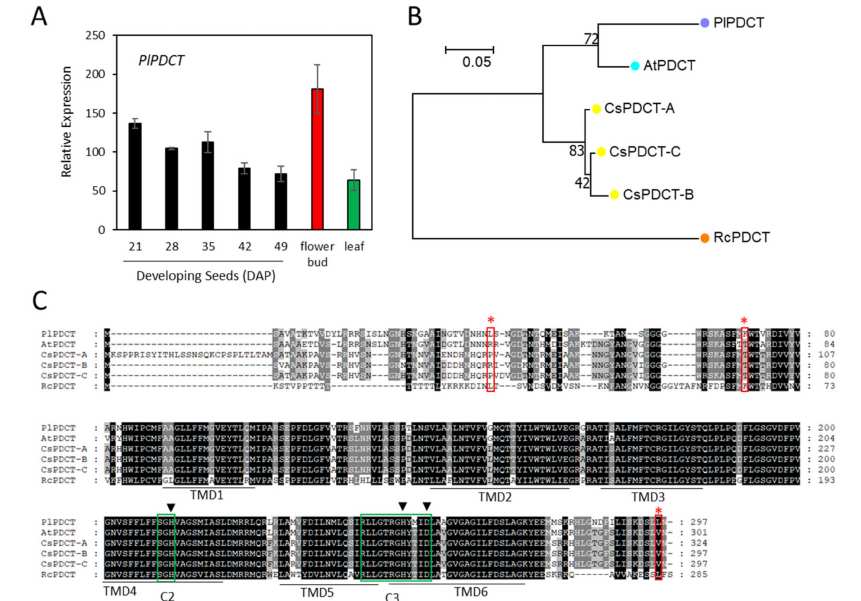
Figure 13. Characterization of PDCTs in various species. ( A ) Relative expression level of PlPDCT in the developing seed, flower, and leaf tissue by qRT-PCR. DAP; day after pollination. ( B ) Phylogenetic tree of PDCT proteins from Physaria lindheimeri , (Pl), Arabidopsis thaliana (At), Camelina sativa (Cs), Ricinus communis (Rc). ( C ) Protein alignment of PDCTs. Putative transmembrane domains were underlined. The red asterisks and boxes indicate the amino acids corresponding to the Leu, Lys, and Leu at the 40th, 71th and 295th positions of PlPDCT. Green boxes are the C2 and C3 domains, where a set of three coordinated amino acids, H-H-D (or His-His-Asp), of a catalytic triad [128] are indicated by arrows. Genbank accession numbers are listed in Supplementary File 6, Table